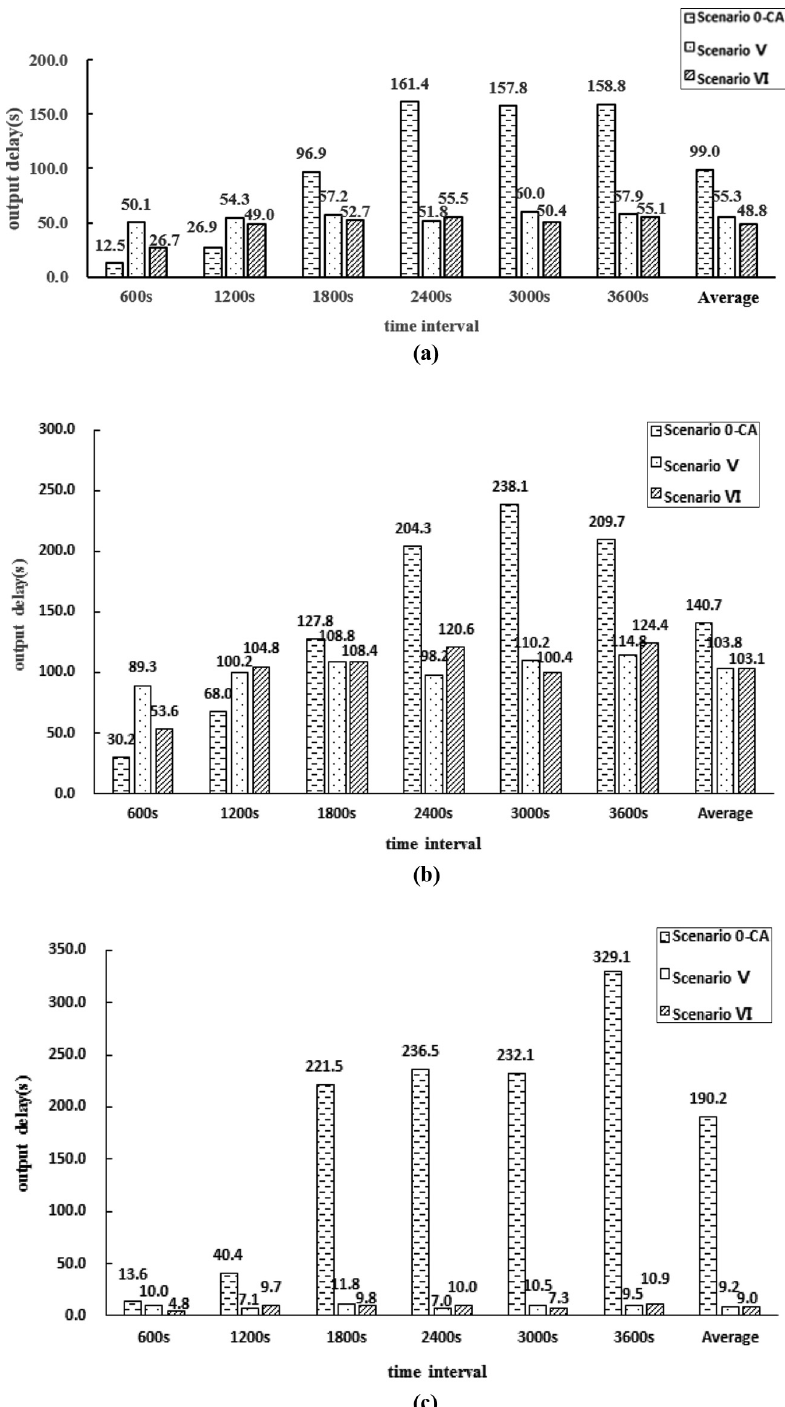
Figure 17 Delays of the current status of Scenario 0-CA, Scenario V and Scenario